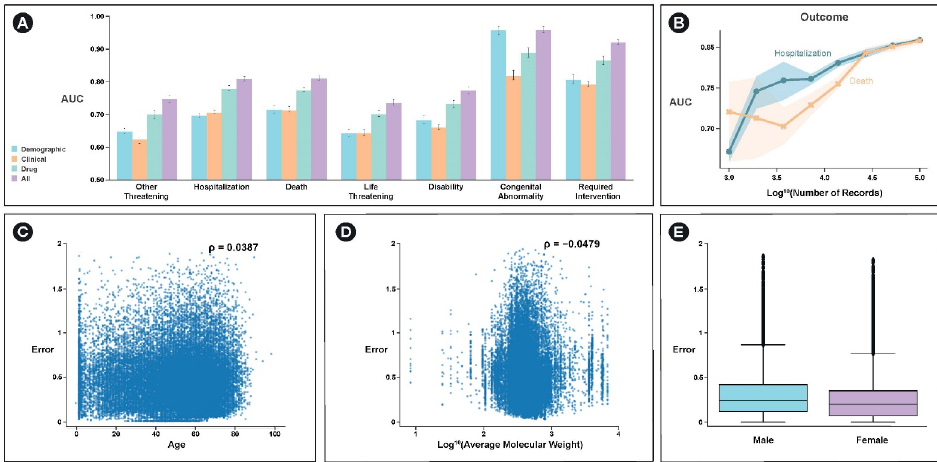
Figure 4. Performance comparisons on the FAERS dataset. ( A ) Predictive utility of various features and model architectures for predicting adverse events in the FAERS dataset. X -axis labels correspond to adverse event categories for a particular case. Y -axis is the AUC at predicting each of the labels. Colors correspond to various feature subsets tested. Error bars correspond to 95% confidence interval derived from bootstrapping on 5-fold cross-validation (each fold contains 28,682 records). ( B ) Power analysis demonstrating improvement in performance as a function of the number of patient records examined. Blue corresponds to hospitalization model performance and orange corresponds to performance of model predicting death. X -axis is log10 (number of records) Y -axis is AUC. Shaded error region corresponds to 95% confidence interval derived from bootstrapping on 5-fold cross-validation in a subsampled dataset corresponding to the X -axis location. ( C ) Plot demonstrating relationship between model error across all outcomes and age, ( D ) average molecular weight of drugs patient is taking, and ( E ) patient sex.